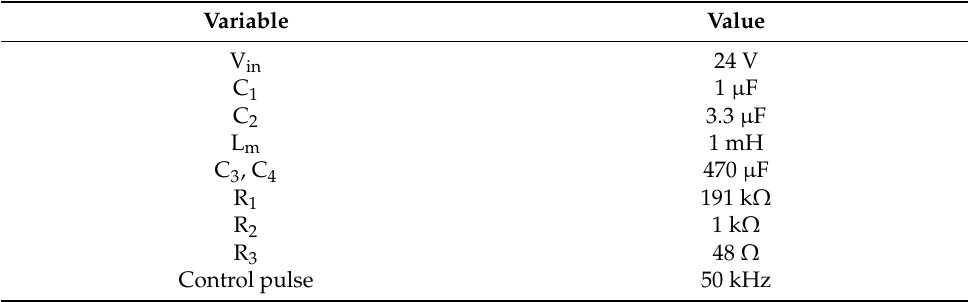
Figure 9. The electrical schematic and test setup. ( a ) Schematic diagram of the LED driver model. ( b ) Real test scenario. Table 5. The circuit parameters of the LED drive model.